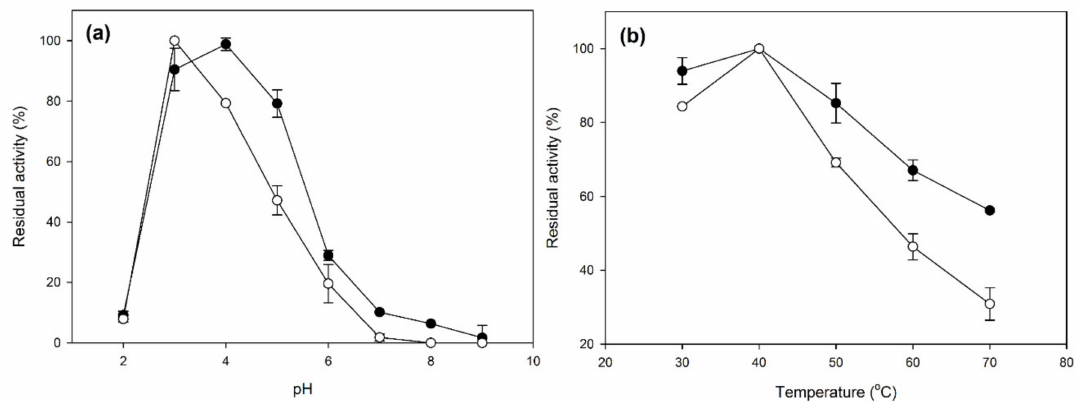
Figure 3. E ff ects of the pH ( a ) and temperature ( b ) on the activity of crude laccase CLEAs (white circles) and crude free enzymes (black circles).